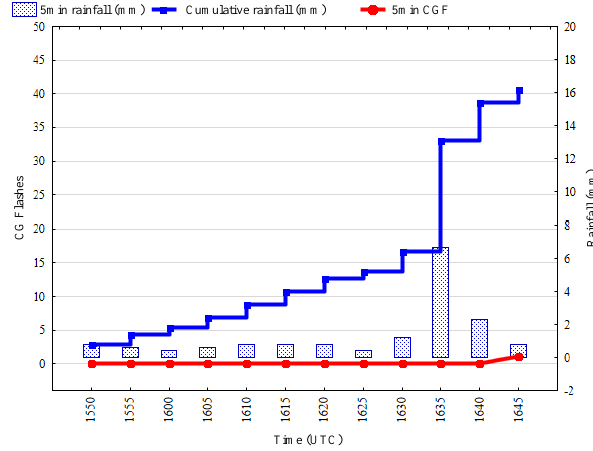
Figure 16. Critical interval time series for debris flow event of 30 September 2000. This is an event from the AL group and de- bris flow initiation was observed at